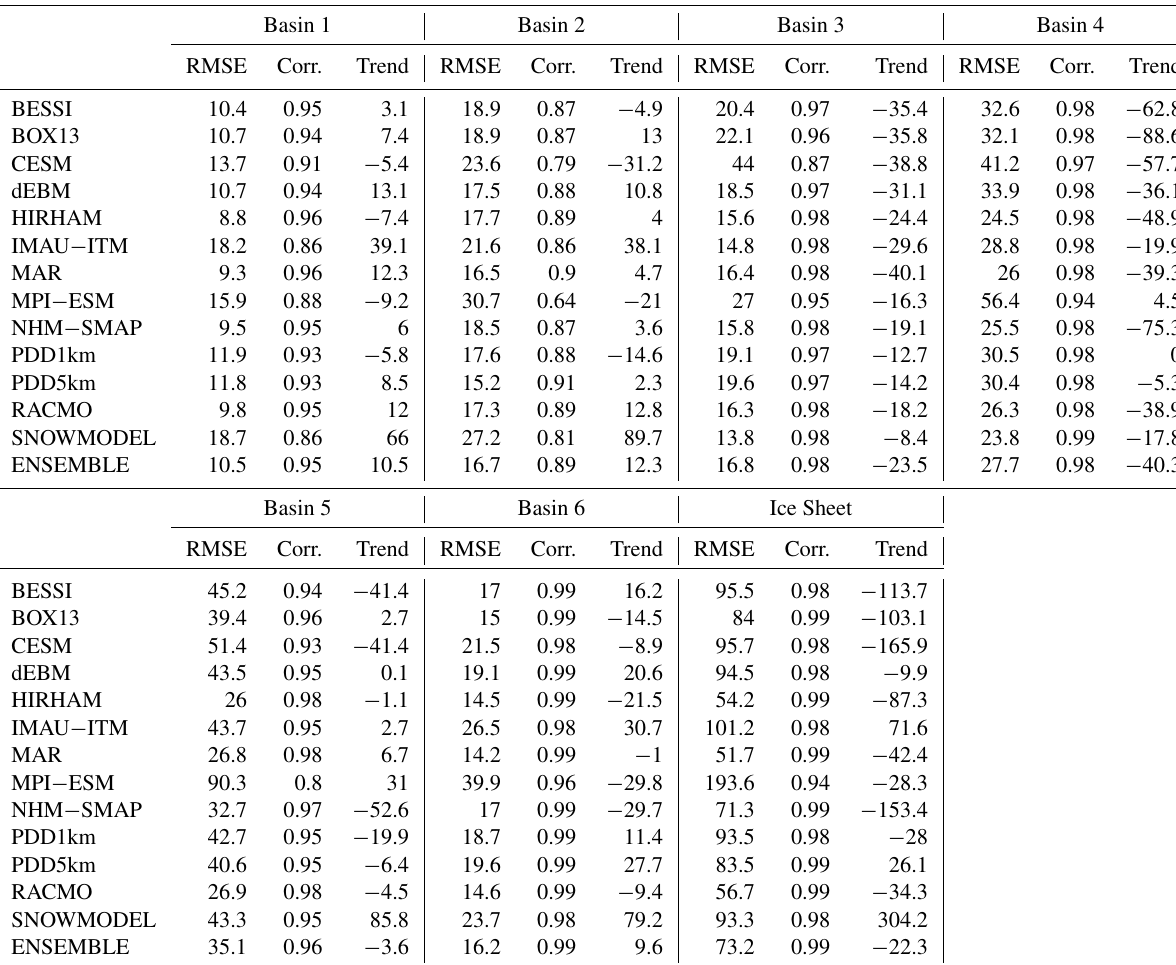
Table 4. Statistics of models (in which the signal coming from the ice discharge has been subtracted from SMB) vs. GRACE for each basin and the whole ice sheet. The trend (in Gtyr − 1 ) shows the linear trend that must be applied to match GRACE estimates. So negative numbers mean that the downward trend is underestimated compared to GRACE. RMSE (root-mean-square error) and correlation are computed after having applied this trend to the modelled time